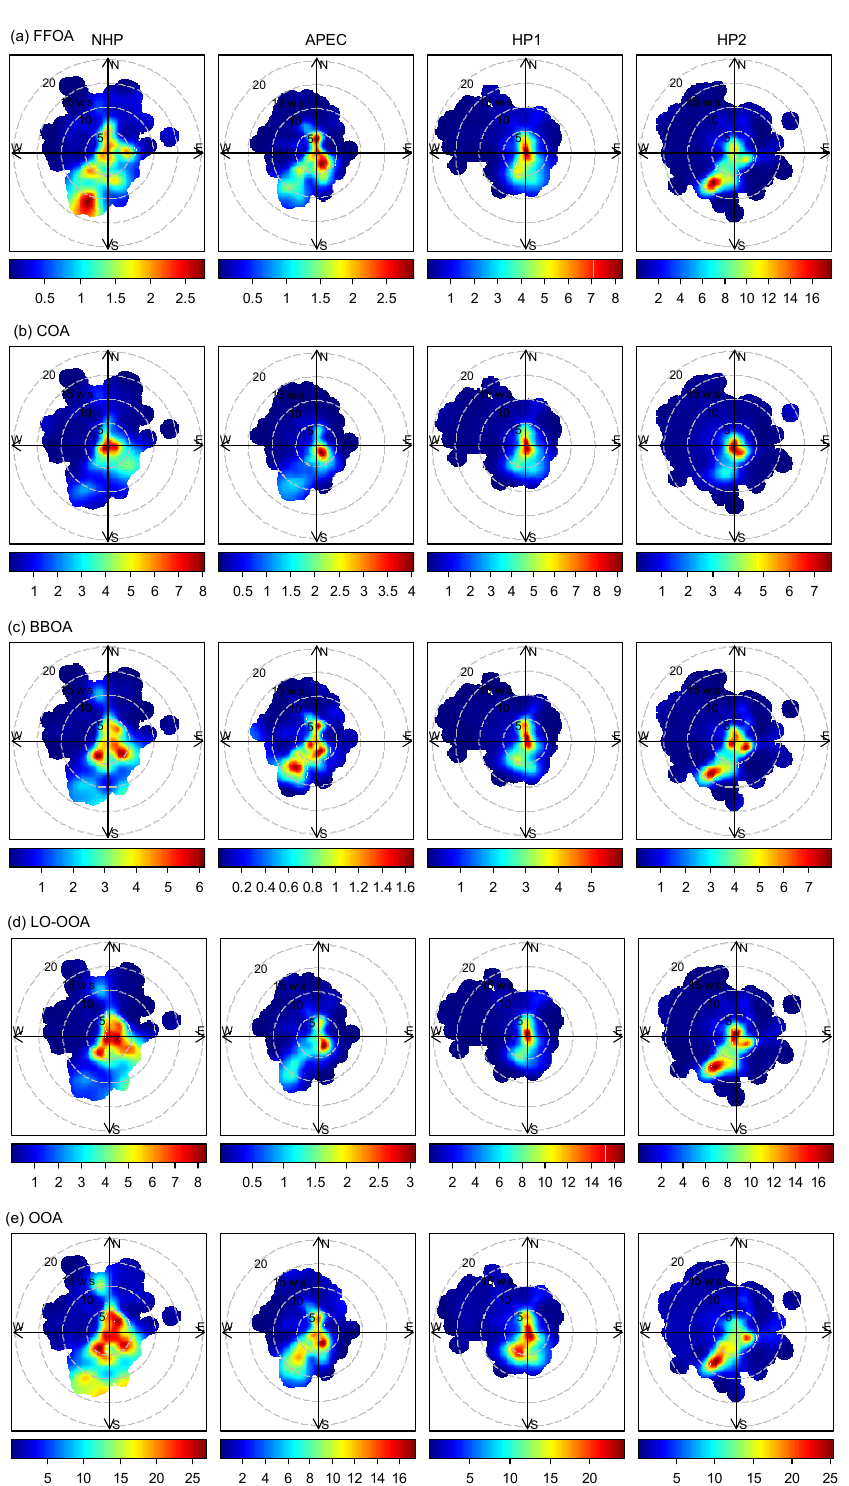
Figure 9. Bivariate polar plots of the mass concentrations of five OA factors (a–e) at 260m as functions of wind direction and wind speed (ms − 1 ) during the four different